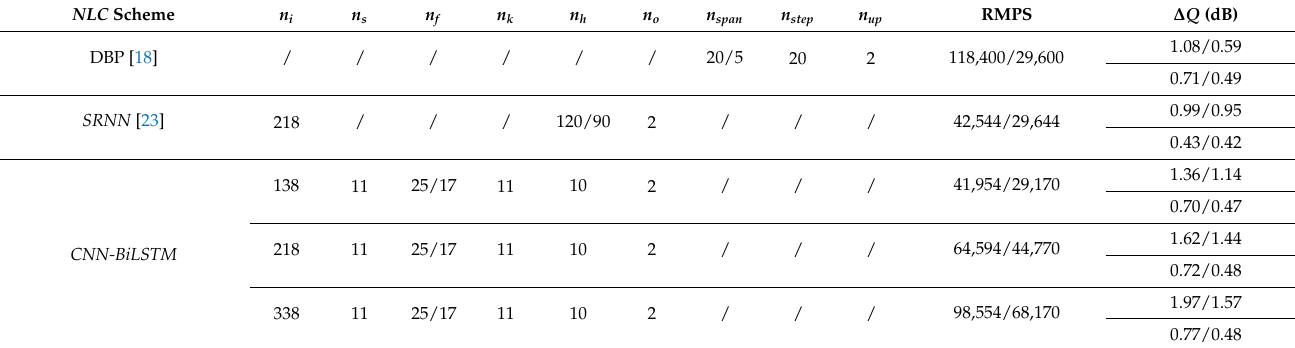
Table 2. Comparison results of specific complexity of different schemes in simulation